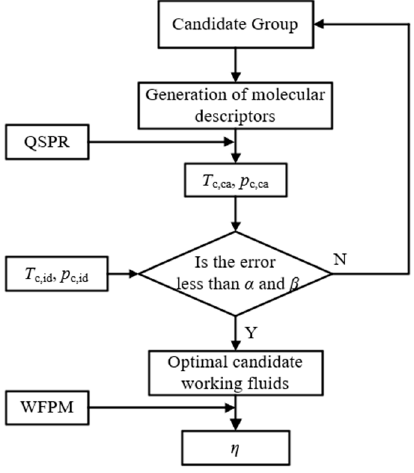
Figure 12. Process of working fluid active design.